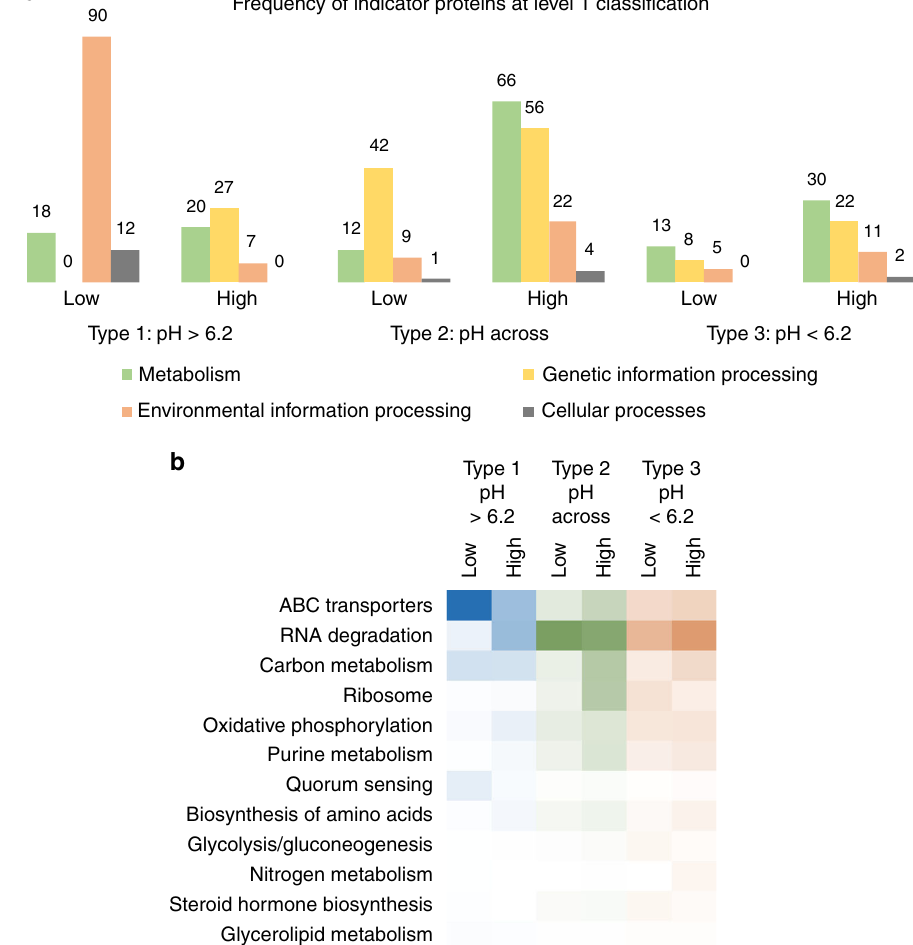
Fig. 5 Functional indicators of land use change. Pairwise protein indicators of land use change in three representative land use contrasts each belonging to the hypothesized land use intensi fi cation effects: a frequency of protein indicators from each soil in KEGG main functional classi fi cation; b relative abundance of the most numerous protein indicators at level 3 classi fi cation, darker hues denote higher abundance. Each contrast consisted of a low and a high land use intensity treatment with three replicates